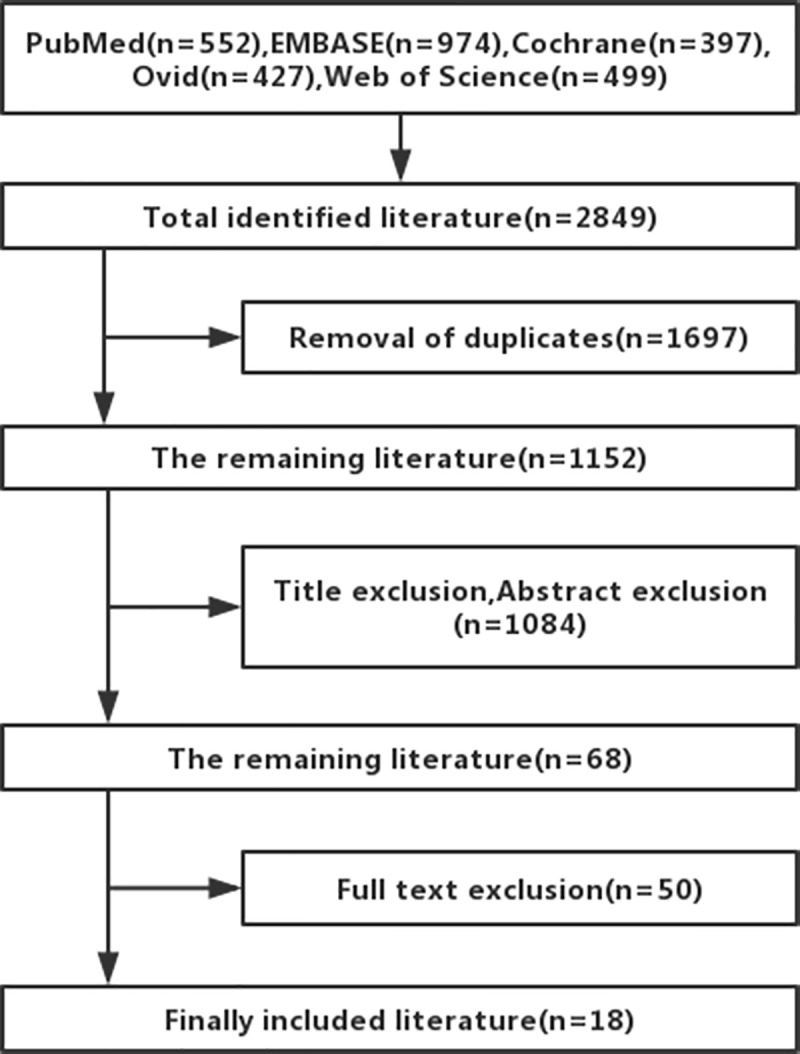
Inclusion of literature search flow chart.